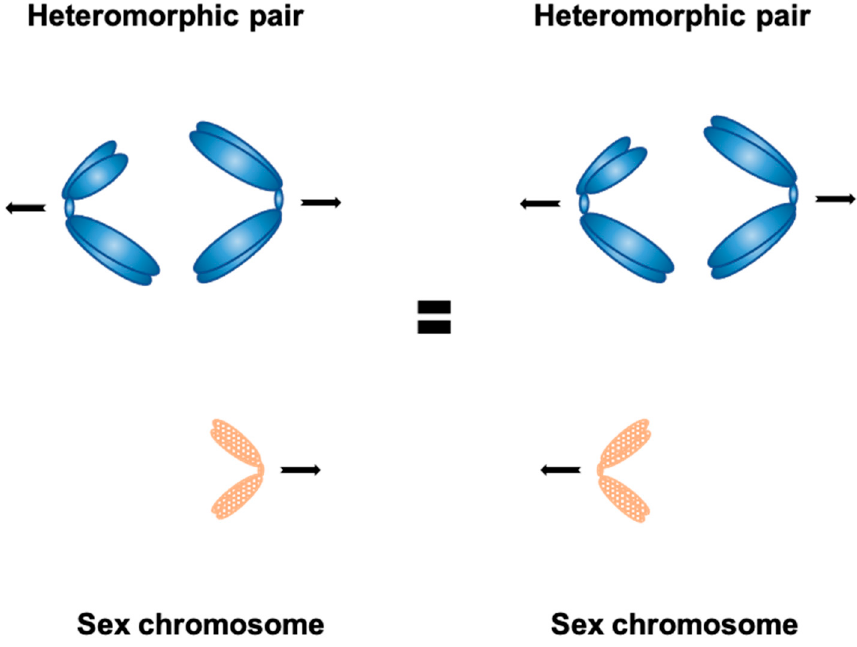
Figure 1. Carothers’ observation in the grasshopper Brachystola —the frequency of accessory (sex) chromosome segregation together with either chromosome belonging to the heteromorphic pair is roughly the same; this led to conclusion that chromosome segregation is generally random.